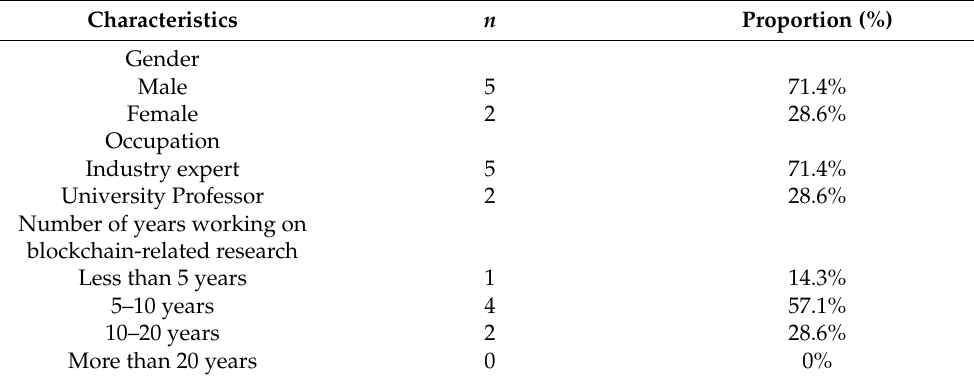
Table 3. Demographic characteristics of the participants ( n = 7).